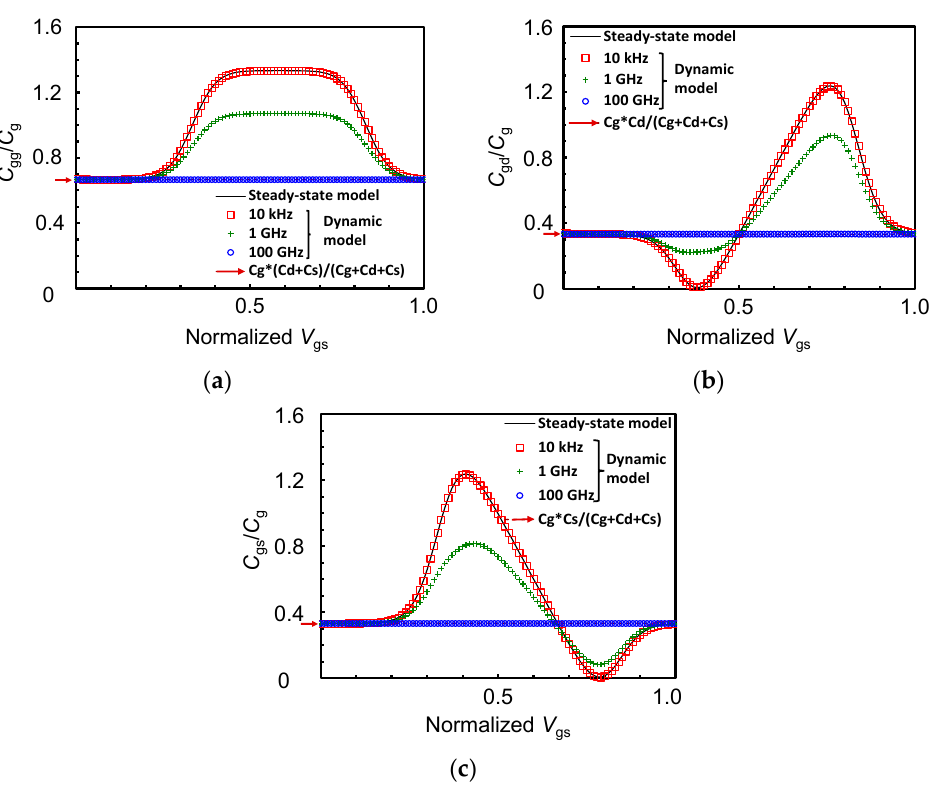
Figure 4. ( a ) SET input capacitance C gg ( b ) drain-to-gate capacitance C gd and ( c ) source-to-gate capacitance C gs as a function of gate voltage V gs for a high drain voltage V ds = 26.7 mV [0.5] at T = 15.5 K [0.05].